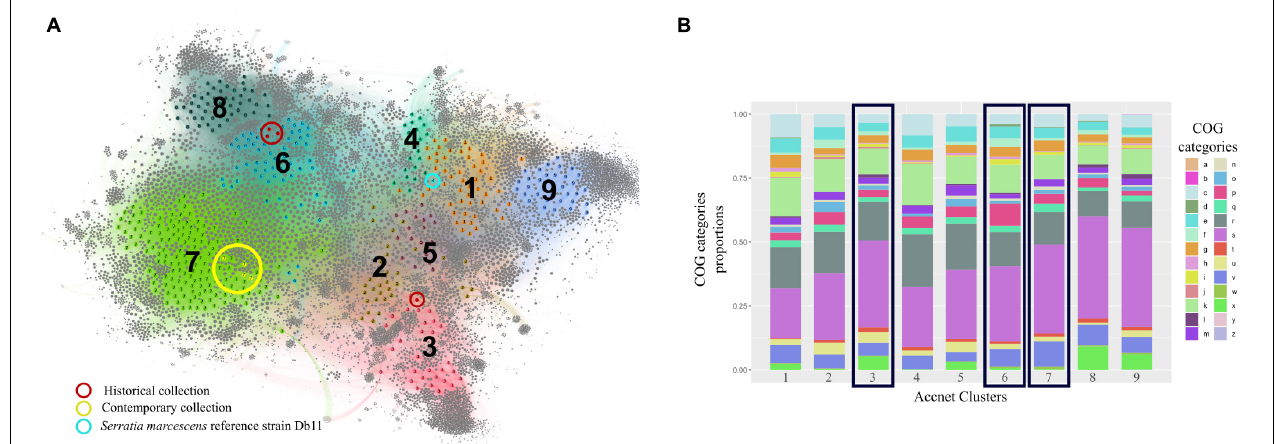
FIGURE 7 | Clustering and analysis of the categorical functions of the accessory genome of the studied Serratia marcescens isolates ( n = 8) and the 444 publicly available genomes by AcCNET software. (A) AcCNET pangenome network with detected clusters ( n = 9) highlighted by colors and numbers. Colored and gray dots correspond to genomes and annotated proteins respectively and are linked by edges. Strains from our collections and the reference genome for S. marcescens species (Db11 strain, assembly accession GCA_000513215.1) are highlighted. (B) Accessory genome functional analysis of the nine detected clusters based on COGs proportions. Black rectangles depict the clusters where strains from our collections belong to. a, RNA processing and modification; b, chromatin structure and dynamics; c, energy production and conversion; d, cell cycle, control, mitosis; e, amino acid metabolism and transport; f, nucleotide metabolism and transport; g, carbohydrate metabolism and transport; h, coenzyme metabolism; i, lipid metabolism; j, translation; k, transcription; l, replication and repair; m, cell wall/membrane/envelope biogenesis; n, cell motility; o, post-translational modification, protein turnover, chaperon functions; p, inorganic ion transport and metabolism; q, secondary structure; r, general function prediction only; s, function unknown; t, signal transduction; u, intracellular trafficking and secretion; v, defense mechanisms; W, extracellular structures; x, mobilome, prophages, and transposons-related proteins; y, nuclear structure; z,